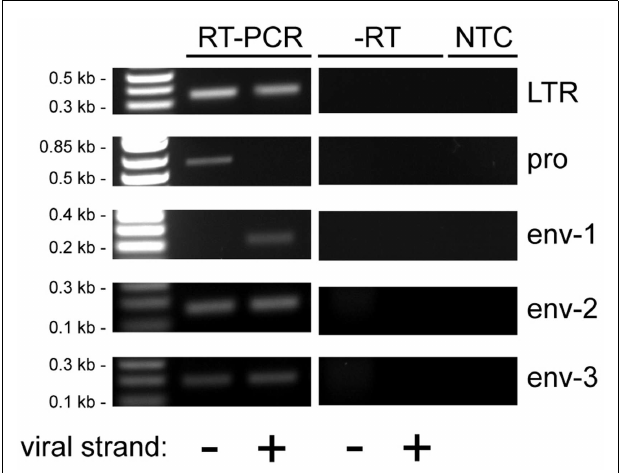
FIGURE 6 | Reverse transcriptase-PCR analysis of HERV-K transcripts in LNCaP cells . Strand-specific, RT-PCR was performed on RNA isolated from LNCaP cells for five different positions in the HERV-K genome using the primer pairs identified in Figure 2 , and the products were resolved by electrophoresis.Viral strand indicates RT-PCR products that originated from viral sense ( + ) or antisense ( − ) RNAs. Parallel controls were performed without reverse transcriptase ( − RT) and without adding any RNA template (NTC, no template control) to exclude DNA contamination. DNA size markers are shown on the